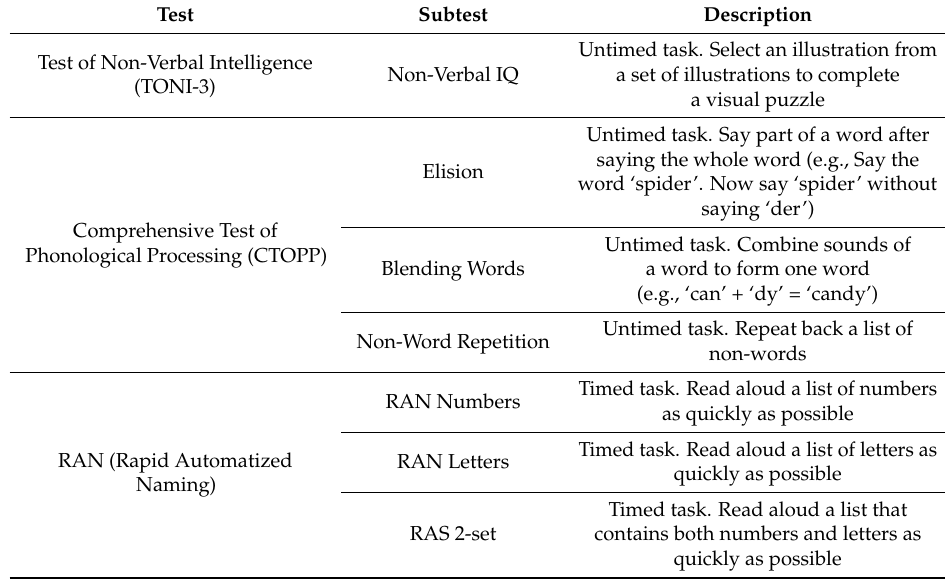
Table 1. Behavioral Reading Battery. Descriptions of the individual tests used to probe participants’ non-verbal intelligence (IQ) and reading subskills in the present study. Specific reading subskills included phonological awareness and rapid